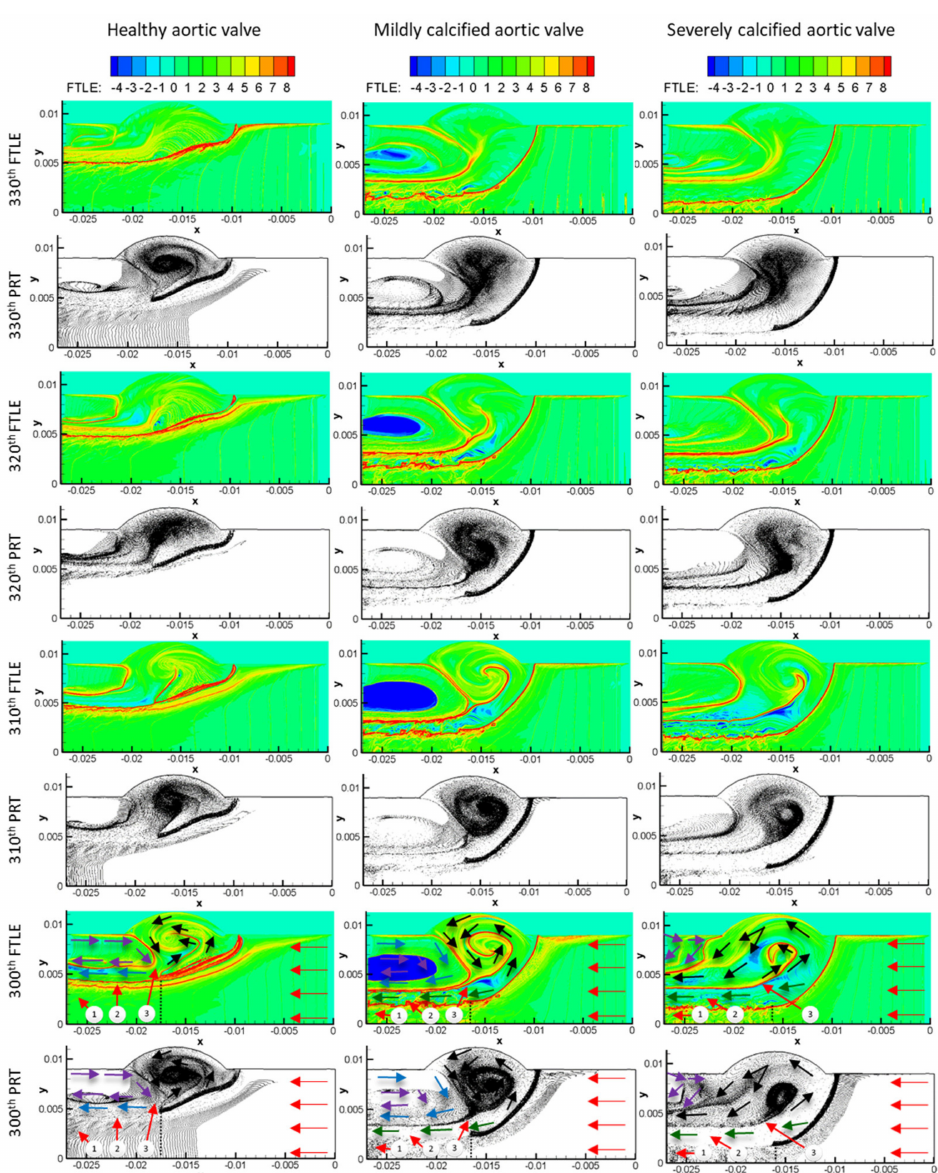
Figure 4. Backward finite-time Lyapunov exponent (FTLE) field plots of healthy ( first column ), mildly calcified ( second column ), and severely calcified ( third column ) aortic